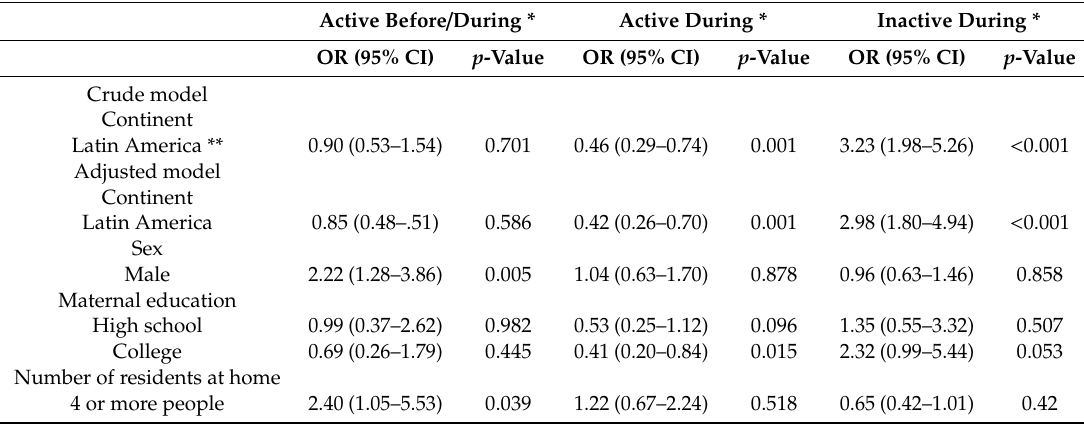
Table 3. Results of the multivariate regression for the physical activity status.